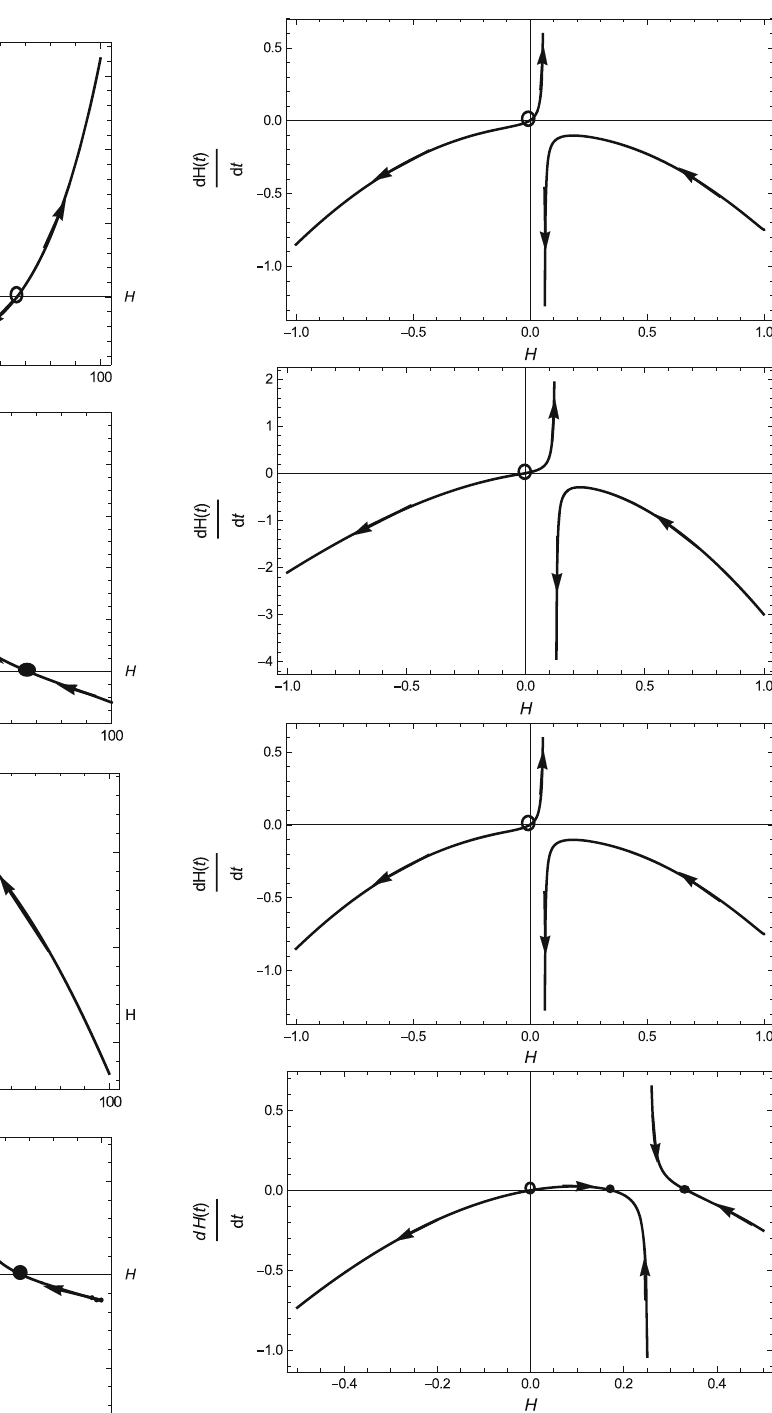
Fig. 13 Phase plot, or ˙ H vs H for different values of ω . For all the cases, C 1 = C 2 = s = 1 (i). Phase plot for ω = 0 . (ii). Phase plot for ω = 1 . (iii). Phase plot for ω =